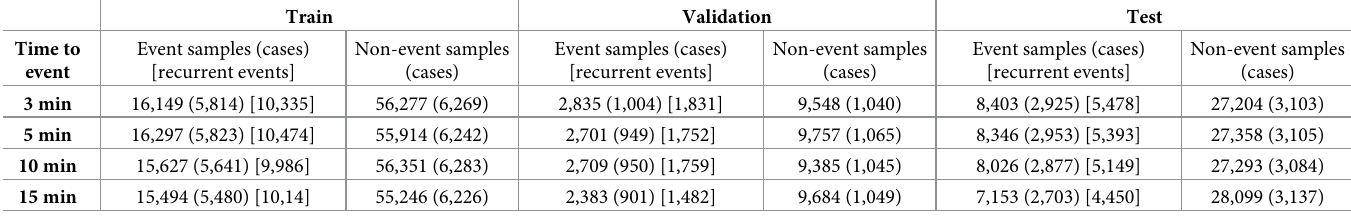
Table 2. Data composition. Train Validation